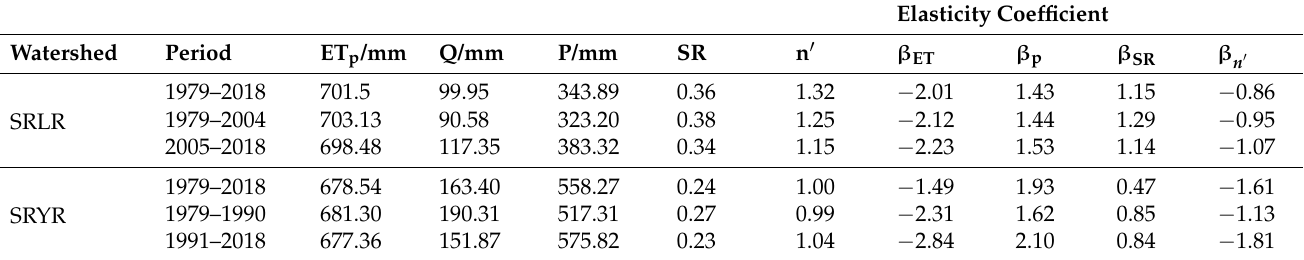
Table 1. Characteristics of hydrometeorological number elements and elasticity coefficients for SRLR and